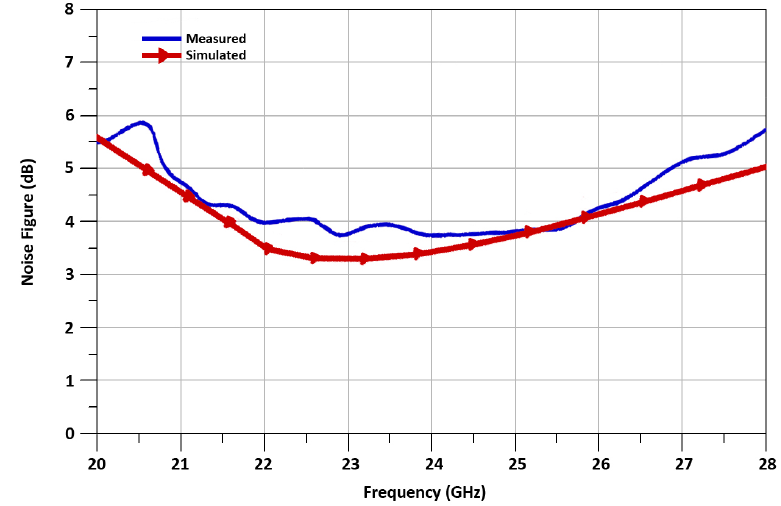
Figure 21. Measured noise figure versus RF frequency.